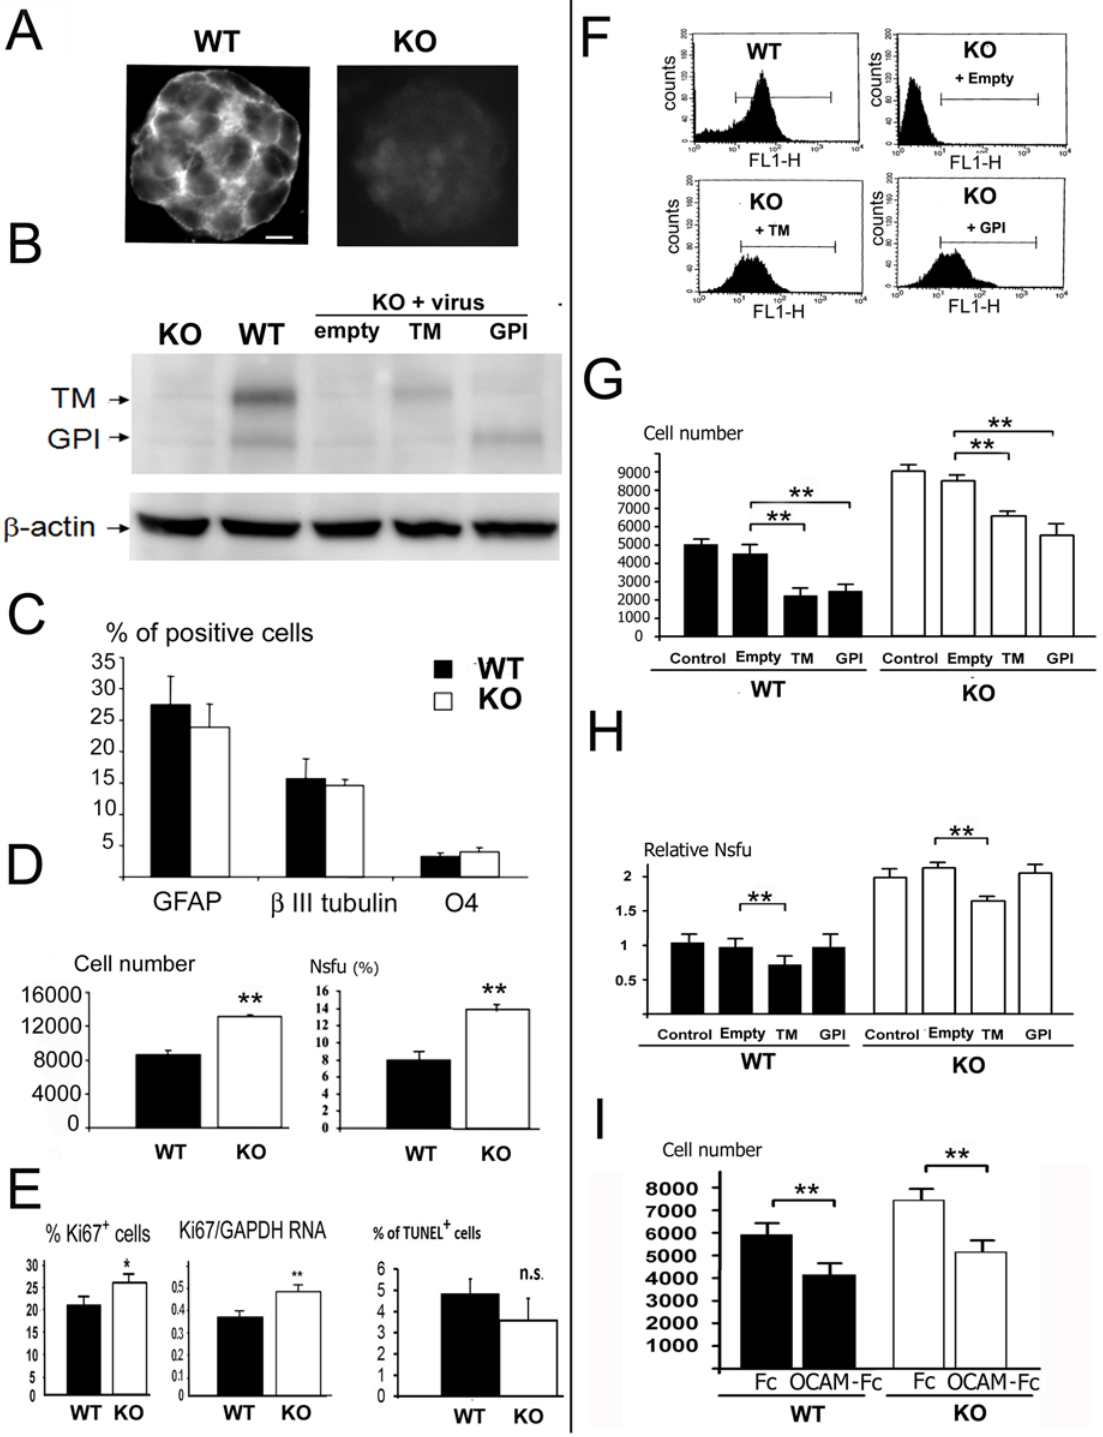
Fig 4. Properties of OCAM KO neurospheres. ( A ): Immunofluorescence detection of OCAM in KO and WT embryonic spinal cord neurospheres. Scale bar = 10 μ m. ( B ): Western blot analysis of OCAM in indicated protein extracts. Vector, TM and GPI indicates OCAM KO neurospheres which were infected with respectively empty, OCAM-TM cDNA and OCAM-GPI cDNA lentiviruses. β -actin was used as an internal control. ( C ): Differentiation of KO and WT cultures. The % of astrocytic, neuronal and oligodendrocytic cells detected by the indicated markers are indicated. No significant difference was observed (n = 10 fields). ( D ): Growth properties of KO neurospheres. Left : Cell numbers obtained 7 days after seeding of indicated cultures (n = 7 wells). Right :